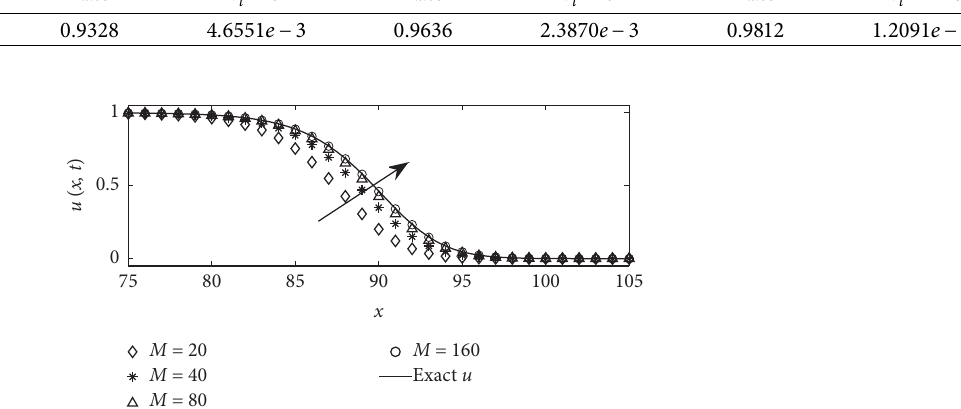
Figure 6: Convergence of the numerical solutions with respect to M values.